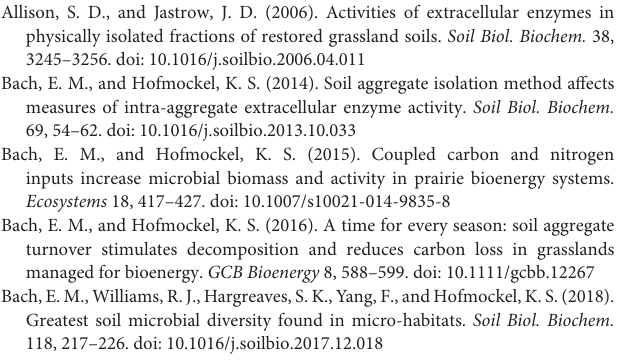
Supplementary Table 2 | All enzymes significantly positively and negatively correlated with cellulose decomposition enzymes in medium